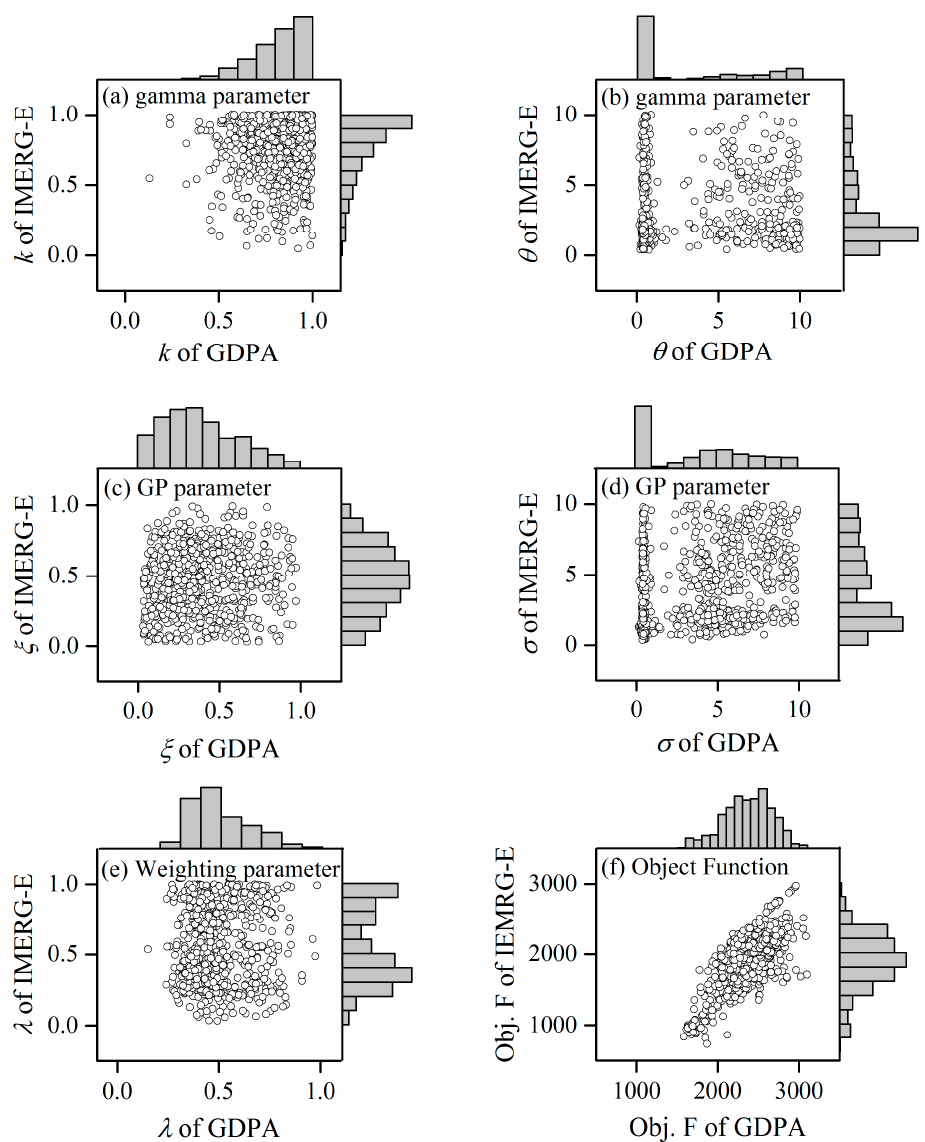
Figure 7. Scatter plot and histogram of parameter set as well as the object function (Obj. F) value used in improved bias correction of CSMD, taking the whole study period time window, i.e., the first scheme of screening time windows, as an example. These parameters were estimated by a simulated annealing algorithm.